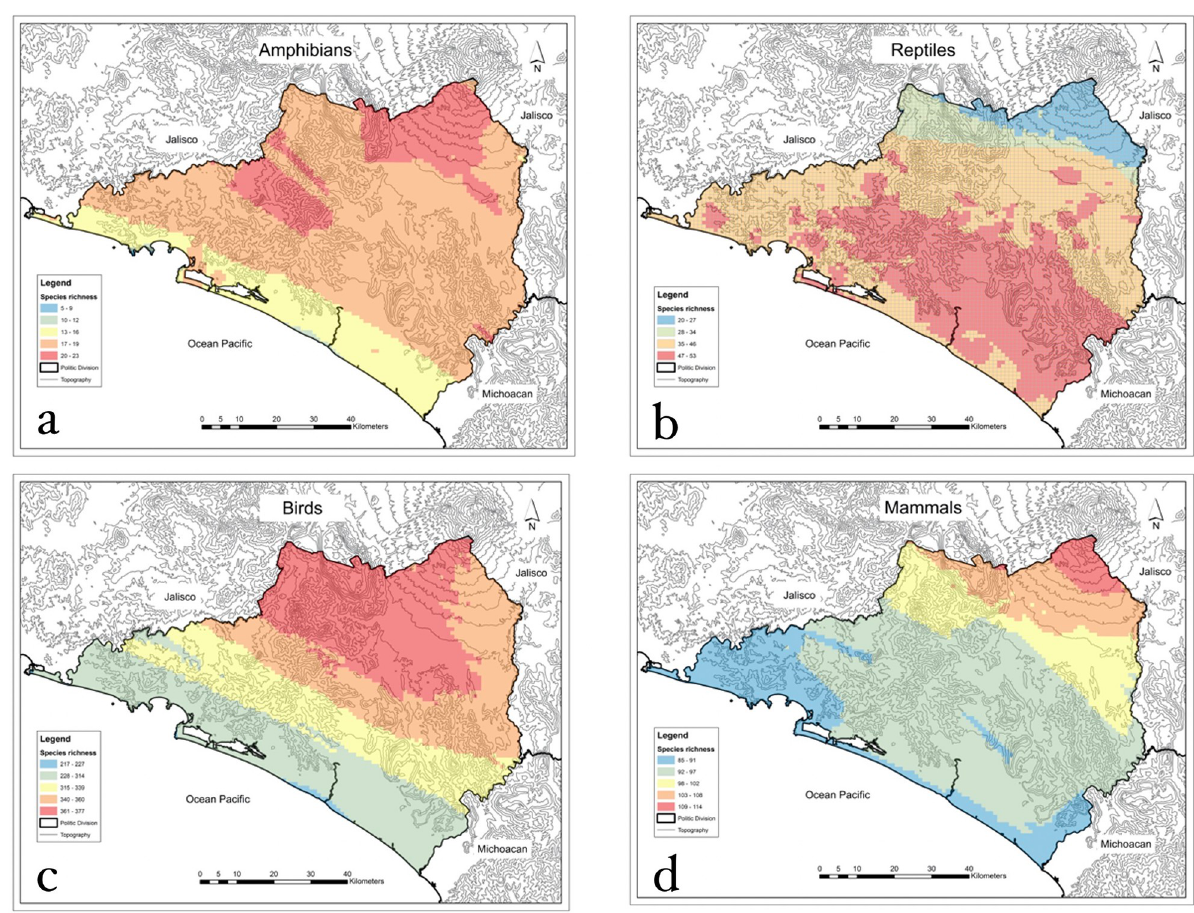
Fig 4. Spatial distribution patterns of species richness by taxonomic group: a) amphibians; b) reptiles; c) birds; d) mammals. Maps were created by A. G. using ArcGIS 10.2.1. software